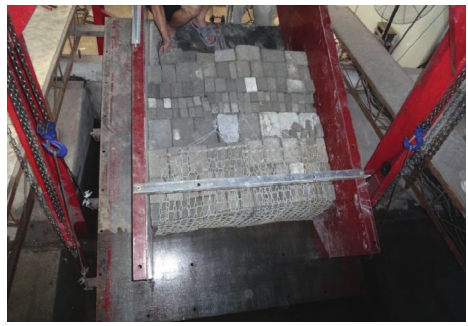
Figure 3: Landslide model in